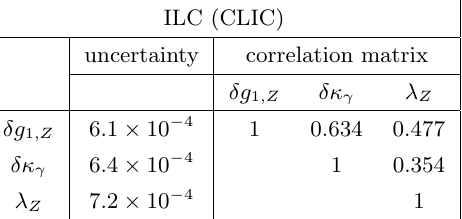
Table 7 . The estimated statistical precision of aTGCs from the e + e in ref. [68], assuming 500 fb (cid:0) 1 of data equally shared between four P ( e polarization con(cid:12)gurations at 500 GeV. We use the same results for CLIC. No scaling with statistics or center-of-mass energy is performed, given that systematic uncertainties may become important.